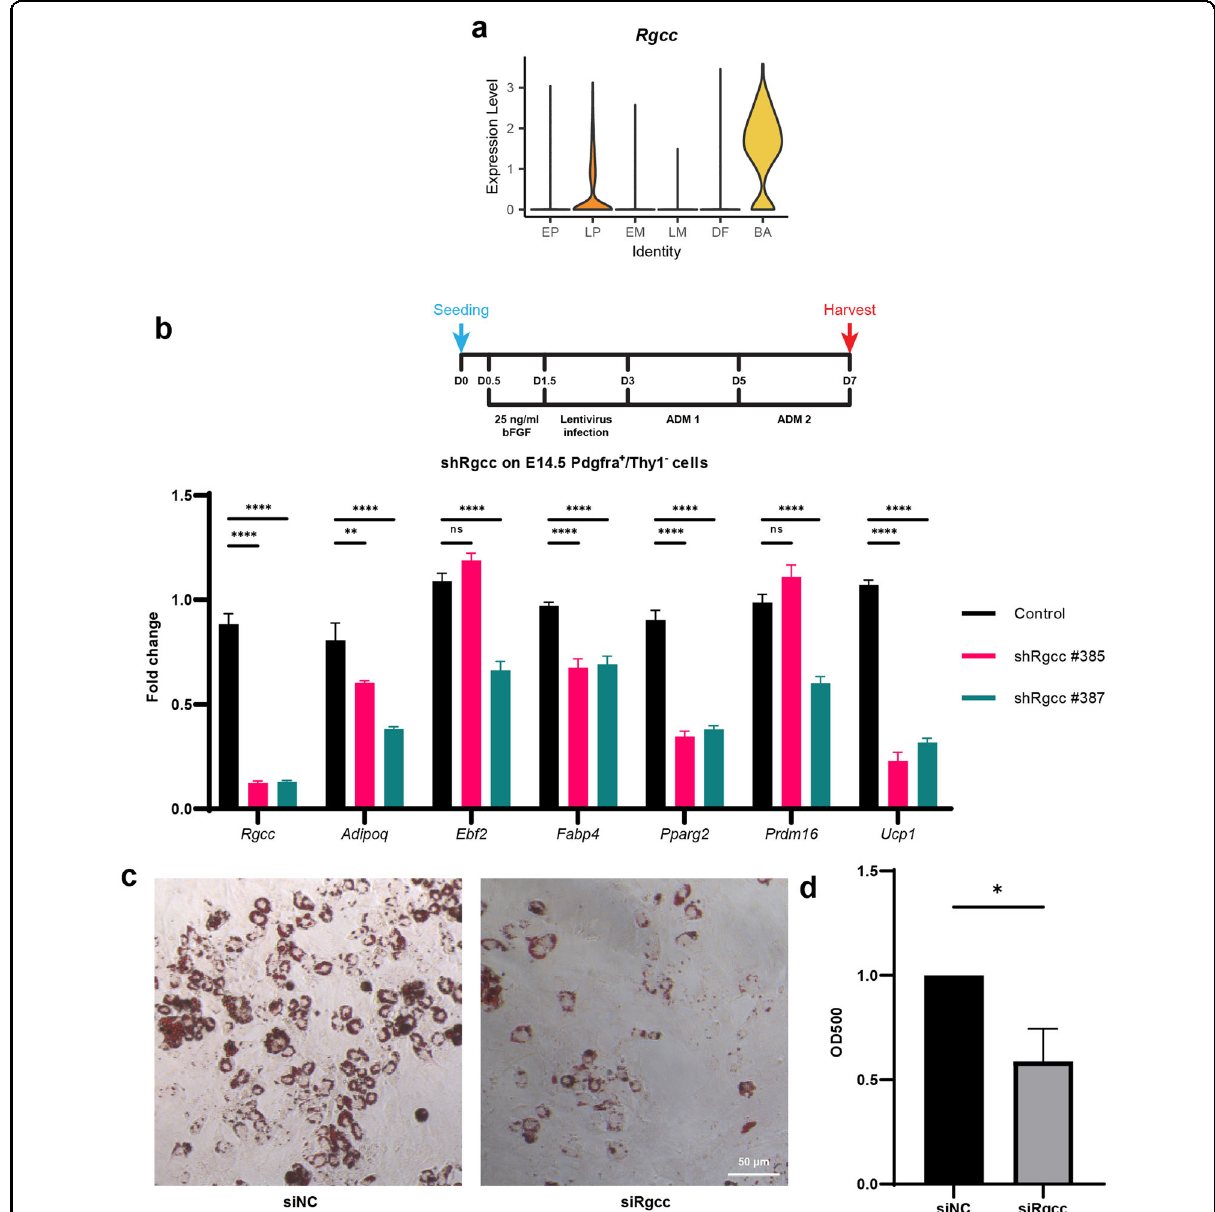
Fig. 6 Cell differentiation inhibition by Rgcc silencing. a Violin plot of Rgcc expression in YFP + cells. b Culture schematic and expression of Rgcc by RT-qPCR on E14.5 Pdgfra + /Thy1 − cells after shRgcc knockdown by lentivirus. Infected cells were cultured in ADM before harvest. Two-way ANOVA was performed, followed by Dunnett ’ s multiple comparisons test. Values are means ± SEM, n = 3; ns, not signi fi cant; ** P < 0.01, *** P < 0.001. c Oil Red O staining of Pdgfra + /Thy1 − cells after siNC (control) and siRgcc knockdown. d Quanti fi cation of Oil Red O staining. Student ’ s t -test was performed between siNC and siRgcc OD500 intensity. * P <